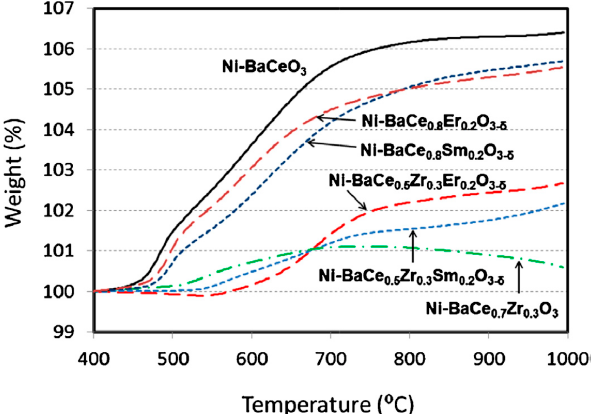
Figure 11. Weight change of reduced Ni-BaCeO 3 , Ni-BaCe 0.7 Zr 0.3 O 3 , Ni-BaCe 0.8 M 0.2 O 3- δ and Ni-BaCe 0.5 Zr 0.3 M 0.2 O 3- δ (M = Sm, Er) cermet powders with increasing temperature in pure CO 2